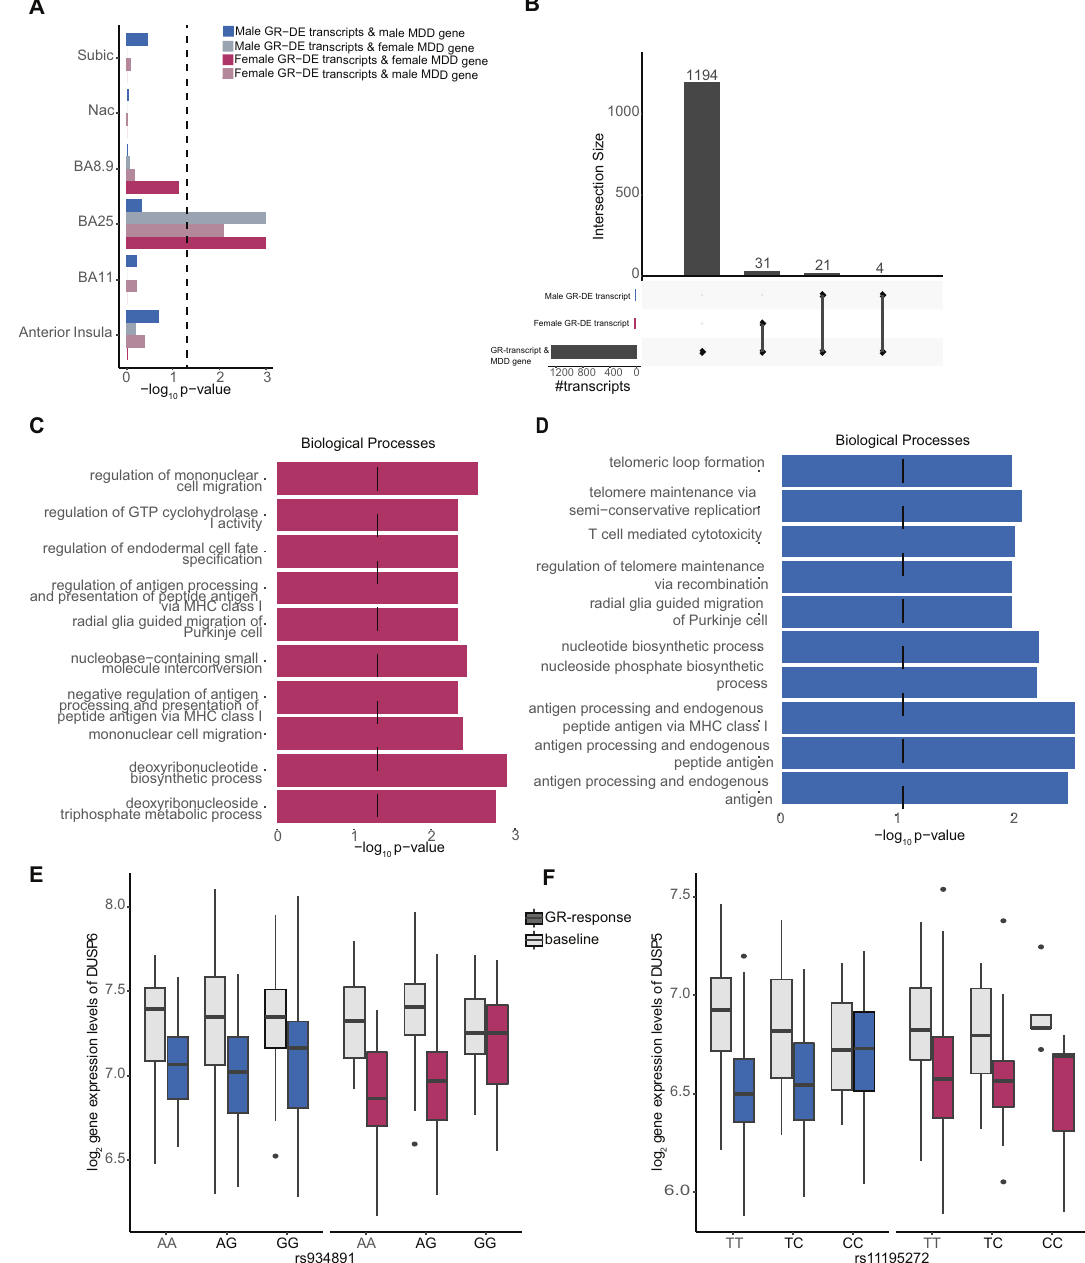
Fig. 5 Sex-strati fi ed GR-response etranscripts in the Brain. Sex-strati fi ed GR-response etranscripts represented in MDD transcriptional patterns: A Bar plot showing the signi fi cance of GR-etranscripts for enrichment in MDD transcriptional pro fi les in six brain regions. Both male and female GR-etranscripts were tested against male and female MDD transcriptional pro fi les. The black line indicates signi fi cance cut-off at a p- value of 0.05 . B Upset plot displaying the overlapping signi fi cant sex-strati fi ed GR-response etranscripts with BA25 MDD-related transcripts. C GO enrichment results for female etranscripts overlapping with BA25 MDD-related transcripts. D GO enrichment results for male etranscripts overlapping with BA25 MDD-related transcripts. E DUSP6 example showing gene expression at baseline and post dexamethasone across genotypes of tag eSNP rs934891 for males and females (female FDR = 0.049). F DUSP5 example showing gene expression at baseline and post dexamethasone across genotypes of tag eSNP rs11195272 for males (male FDR = 0.046) and